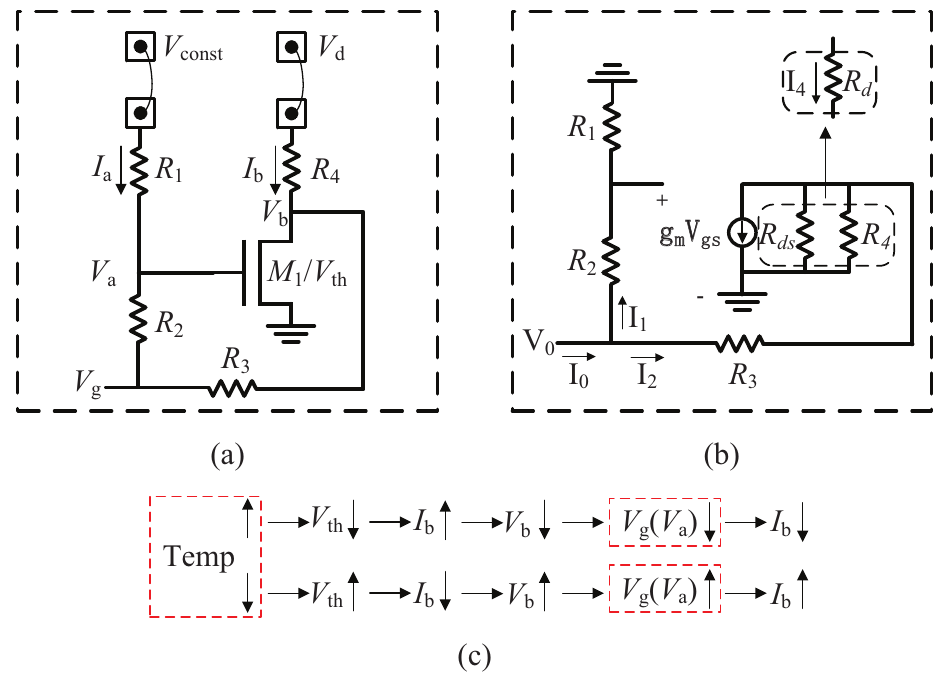
Figure 6. ( a ) Schematic of the temperature compensation bias circuit. ( b ) Equivalent small-signal model of the temperature compensation bias circuit. ( c ) Current and voltage change direction with